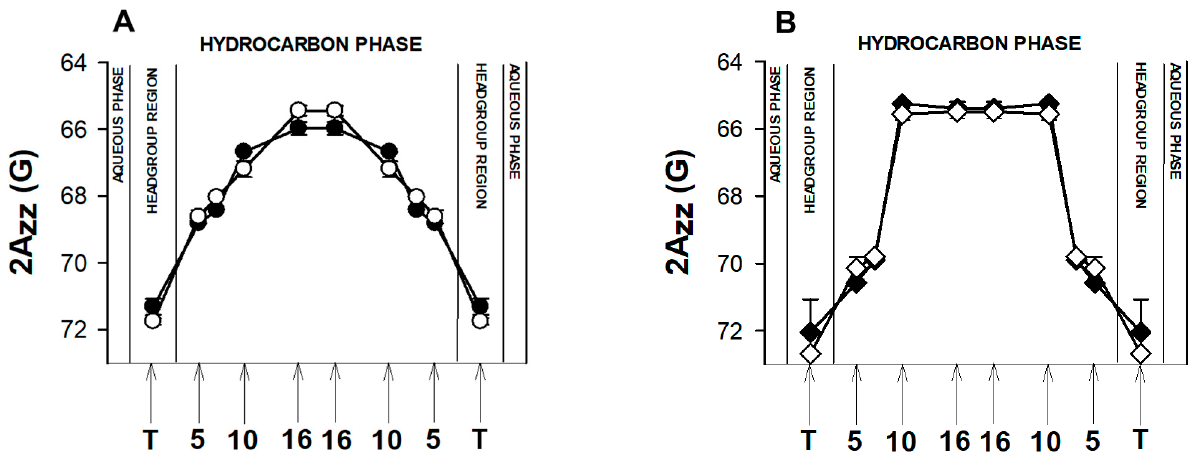
Figure 6. Polarity profiles across POPC/DMPE membranes containing 5 ( A ) or 40 ( B ) mol% cholesterol. The spectra were acquired at 120 K. Upward changes of 2Azz indicate a decrease in polarity. Full symbols denote a control membrane and empty symbols—a membrane containing 5 mol% TUDCA. Approximate locations of the nitroxide moieties of spin labels are indicated by arrows